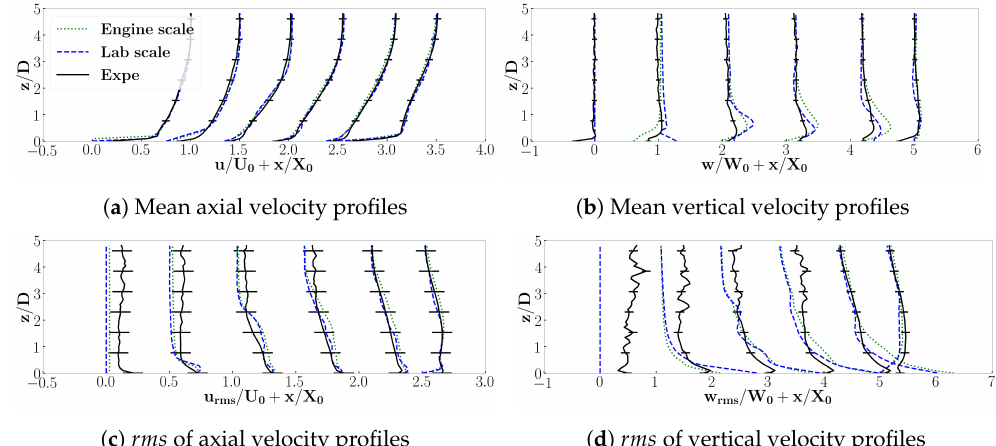
Figure 10. Comparison of time-averaged axial (u) and wall-normal (w) velocities and associated RMS values for lab and engine scales with experimental data, without turbulence injection at the locations × provided in Figure